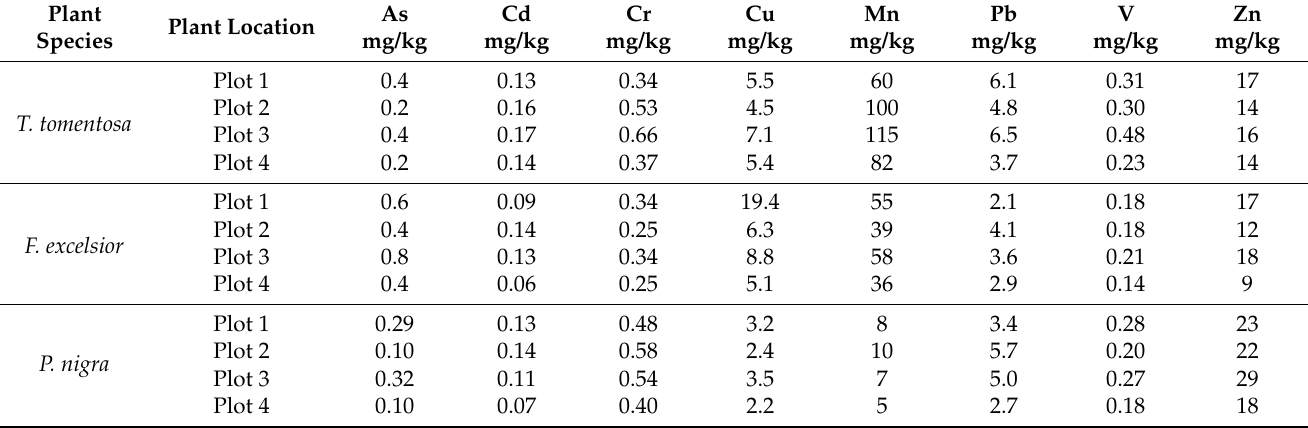
Table 3. Concentrations of some potentially toxic elements (PTEs) in tree leaves/needles (in mg/kg) in August 2015—4 months after transplantation into the urban